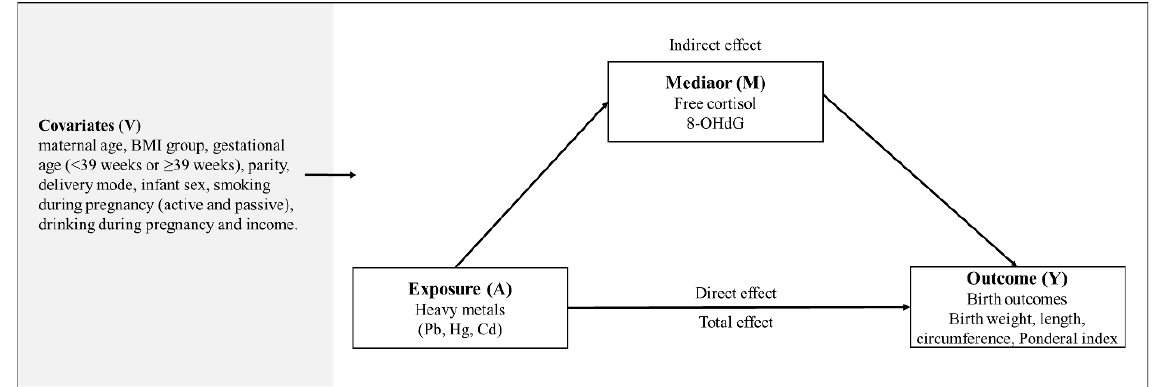
Figure 2. Conceptual model of mediation analysis in the present study.